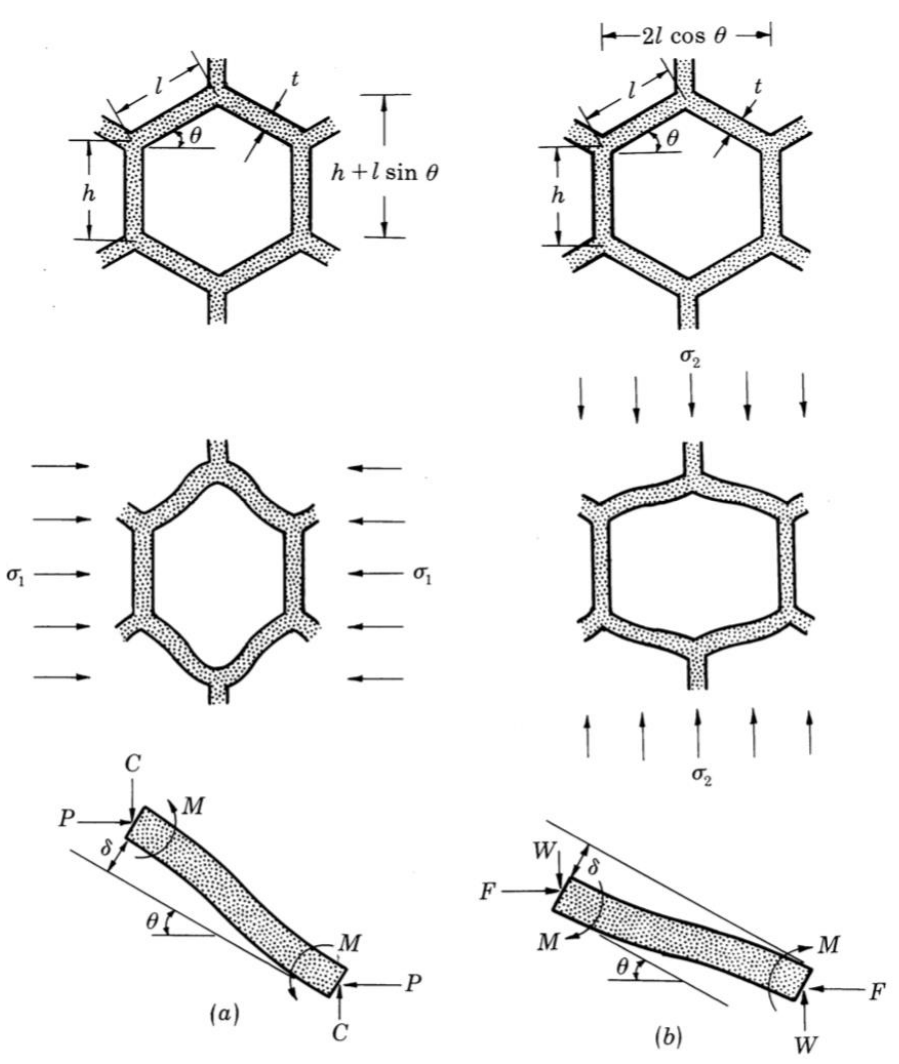
Figure 6. Beam theory analysis on honeycomb structure [13]. ( a ) and ( b ) represents structures under two different directional forces